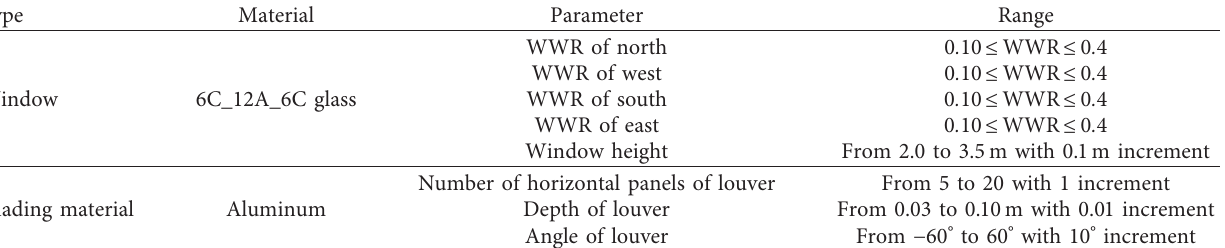
Table 2: Design variables and ranges of values.